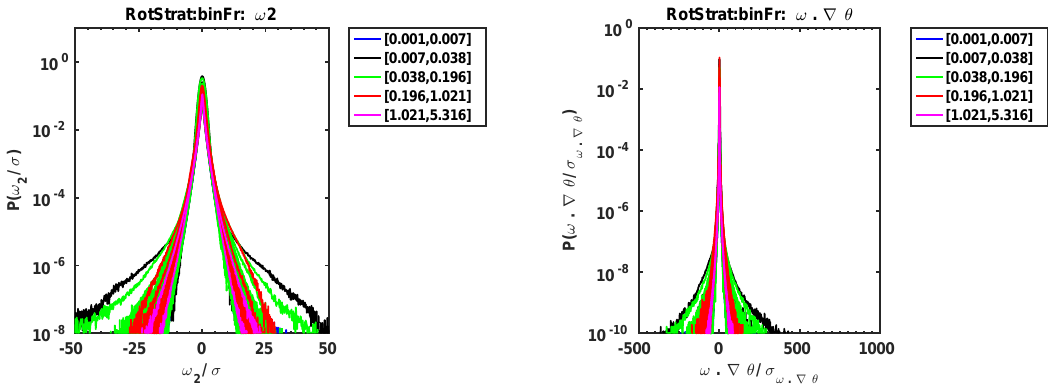
θ ( right ), both binned in Froude number Fr · ∇ 0.196), corresponding to the ≤